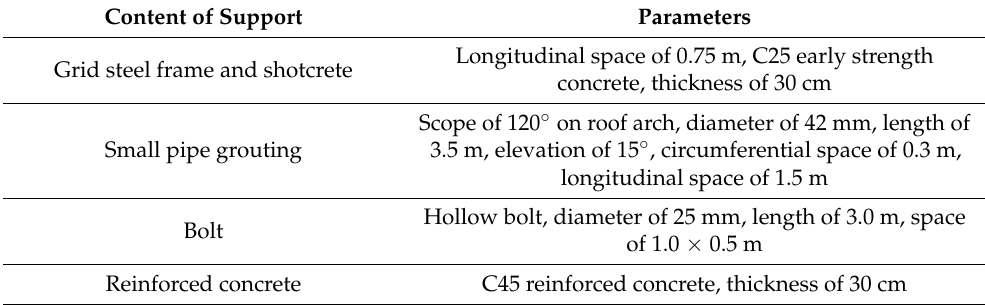
Table 3. Support design in